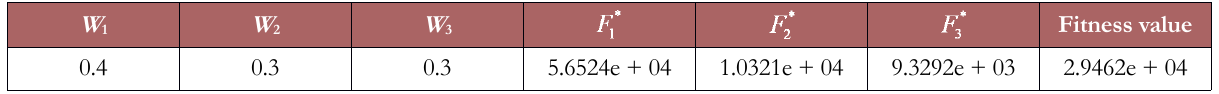
Table 3. The optimal objective values of the case problem